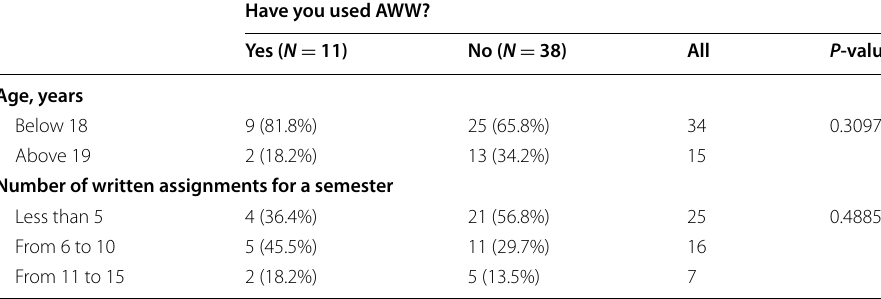
Table 9 Comparison of nominal variables by “Used AWW” Have you used AWW?